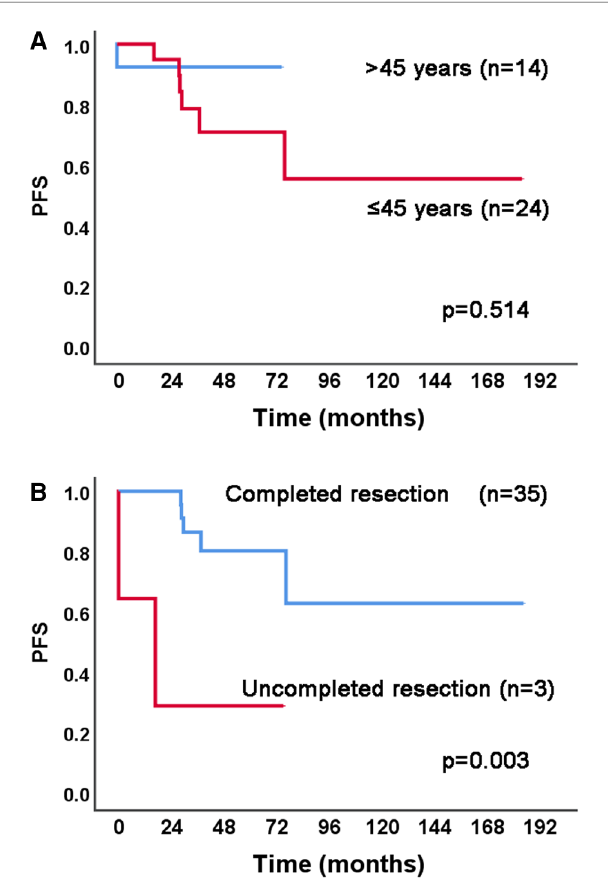
FIGURE 2 Kaplan – Meier analysis of high-risk factors for PFS in 361 IVL patients. PFS, progression-free survival; IVL, intravenous